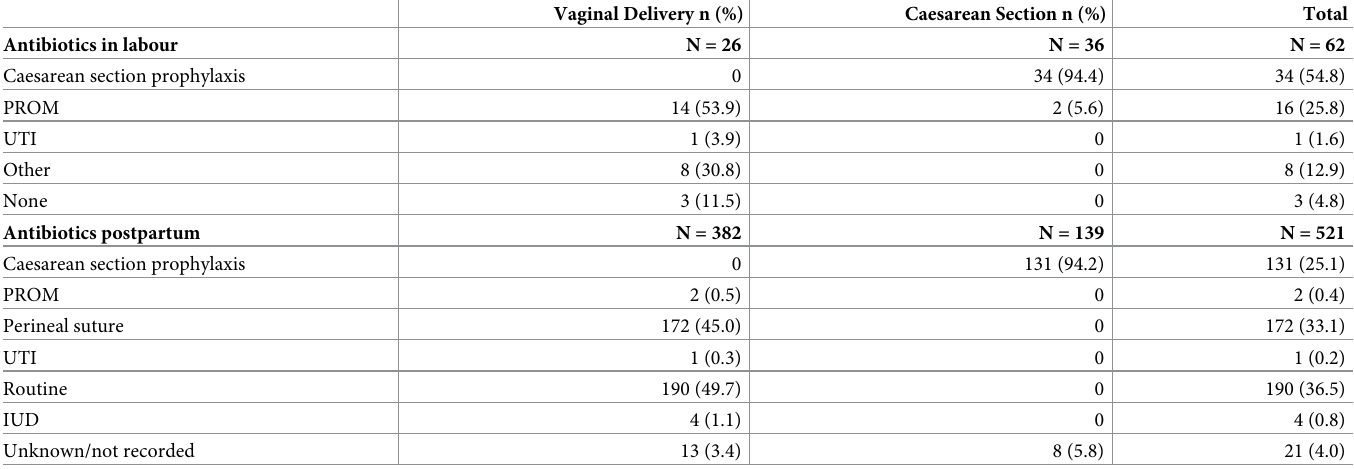
Table 3. Reason for antibiotics prescribed to women in hospital during labour and postpartum by delivery mode.